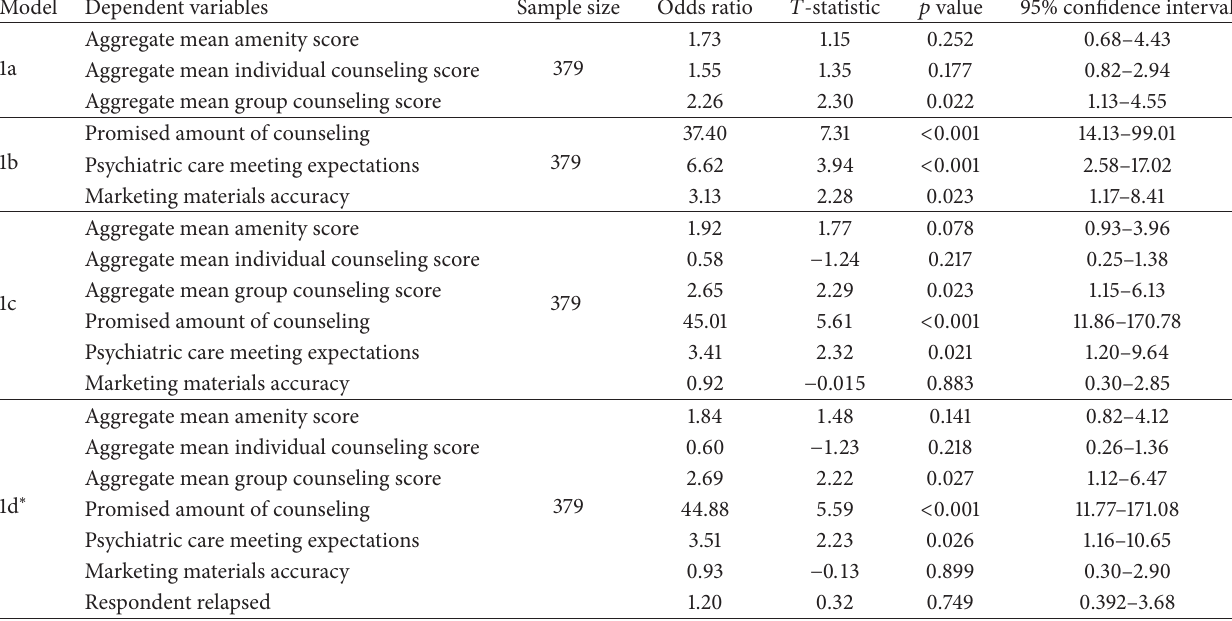
Table 3: Regression outcomes